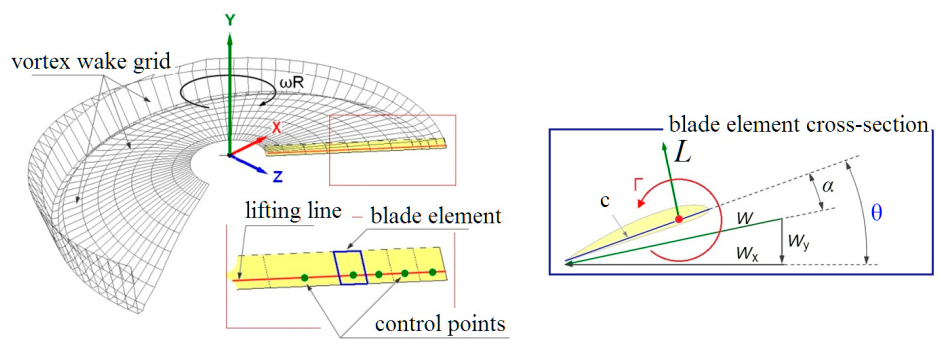
Figure 1. Free wake model.